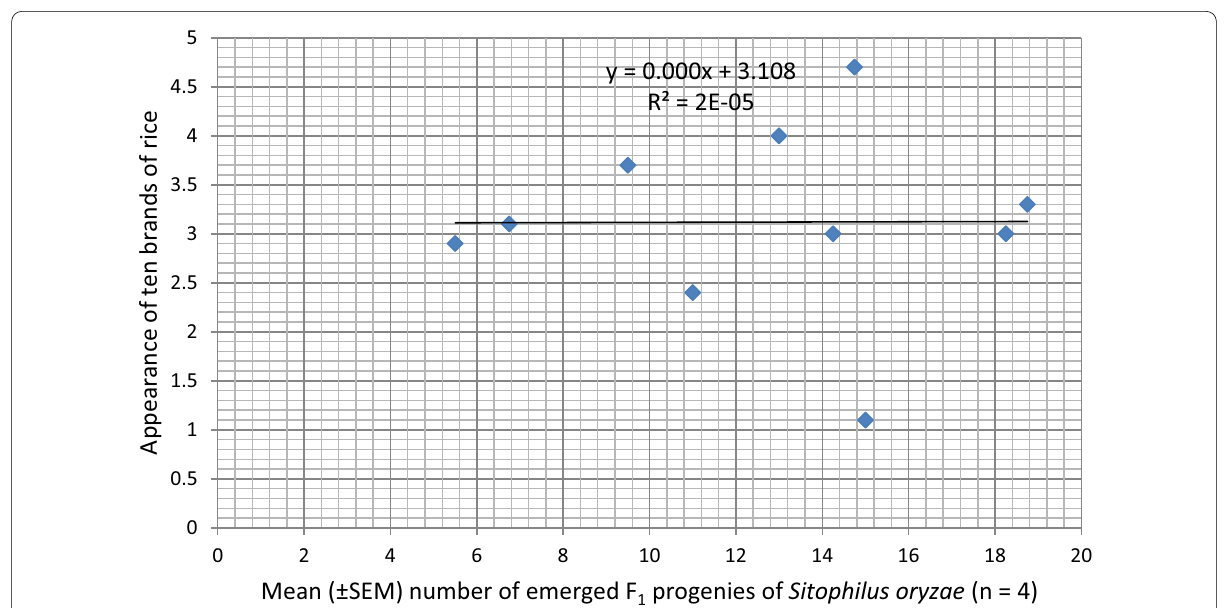
Fig. 4 Association between rice brand appearance and number of F 1 progenies of Sitophilus oryzae